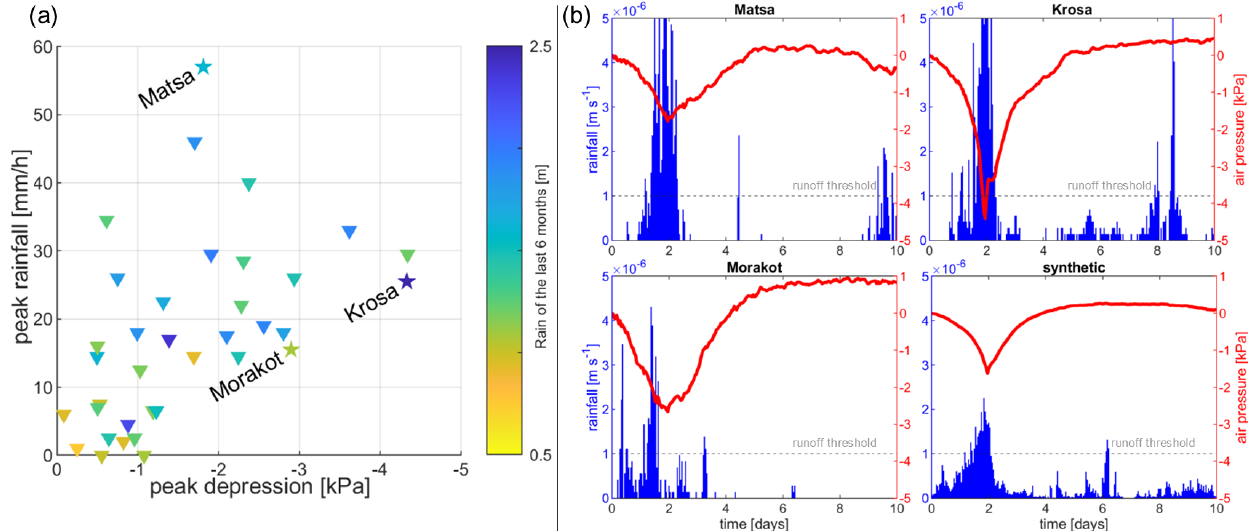
Figure 5. (a) Typhoons over Taiwan sorted as a function of their maximum rainfall intensity and atmospheric pressure drop. The hydrological context is represented by the colour scale, showing the cumulated rainfall over the 6 months before the event. (b) Time series of rainfall and atmospheric pressure changes of the three typhoons and the synthetic event created from the average of every